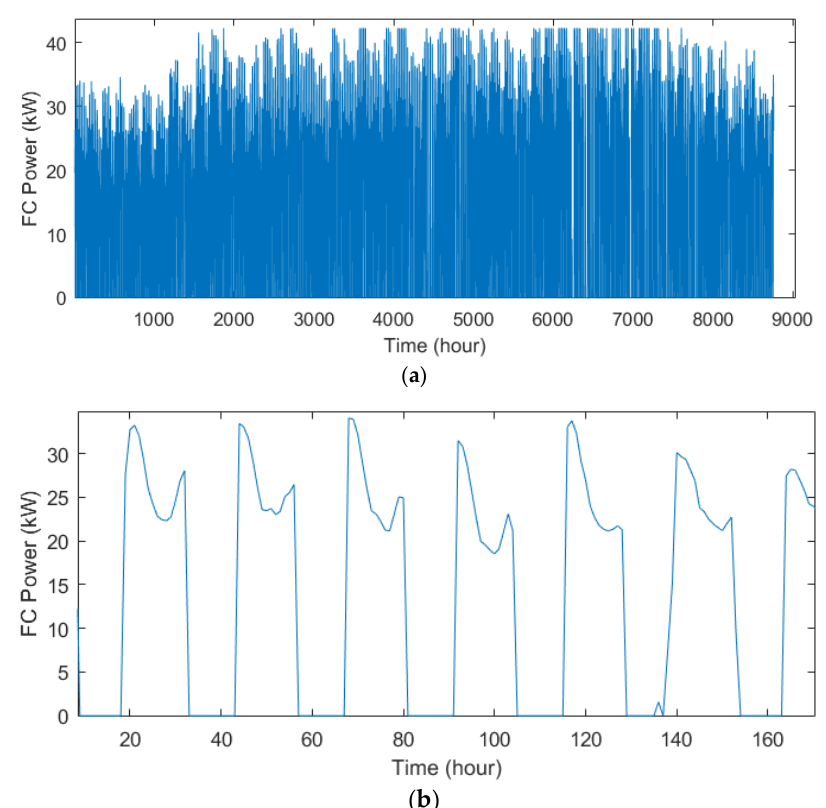
Figure 16. FC power in the sizing of the HPV/FC energy system via the IAEO, considering ENSP max = 5% during ( a ) a year and ( b ) a week.